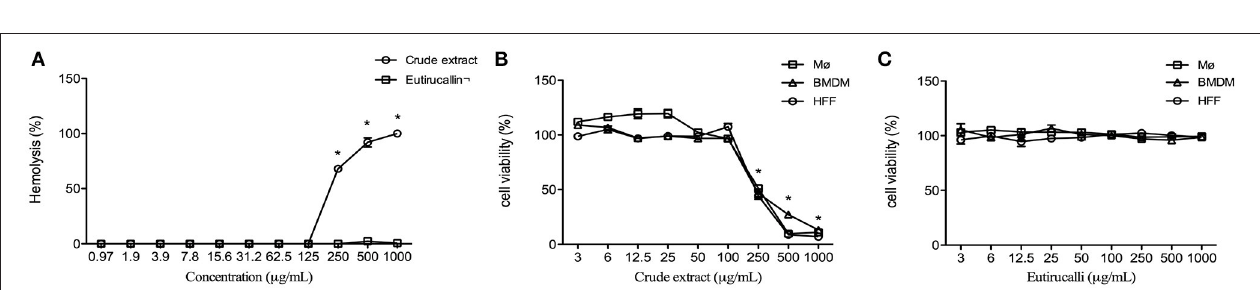
FIGURE 3 | Hemolysis and cytotoxic effects of crude extract and Eutirucallin against non-tumoral cells lineages. (A) Percentage of hemolysis in mouse red blood cells, indicating that crude extract is cytotoxic whereas Eutirucallin is not, even at higher concentrations. * P < 0.05 compared to Eutirucallin. (B) Percentage of cell viability in bone marrow derived macrophage (BMDM), peritoneal macrophage (Mø) and Human Foreskin Fibroblast (HFF) showing that all cells are sensitive to crude extract at concentrations greater than 100 µ g/mL. * P < 0.05 compared to 100 µ g/mL (C) . Percentage of cell viability in BMDM, Mø and HFF demonstrating the non-cytotoxic effects of Eutirucallin even at higher concentrations. Bars represent standard errors.